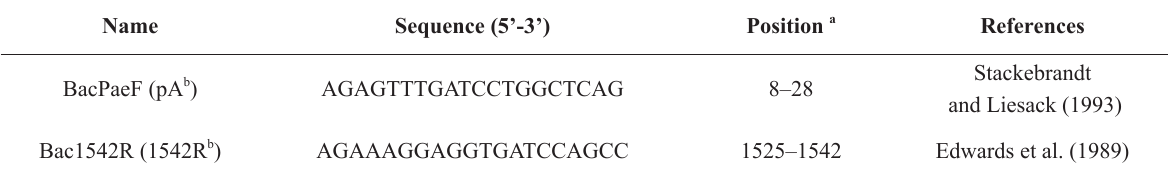
Primers used for the sequence of 16S rDNA of